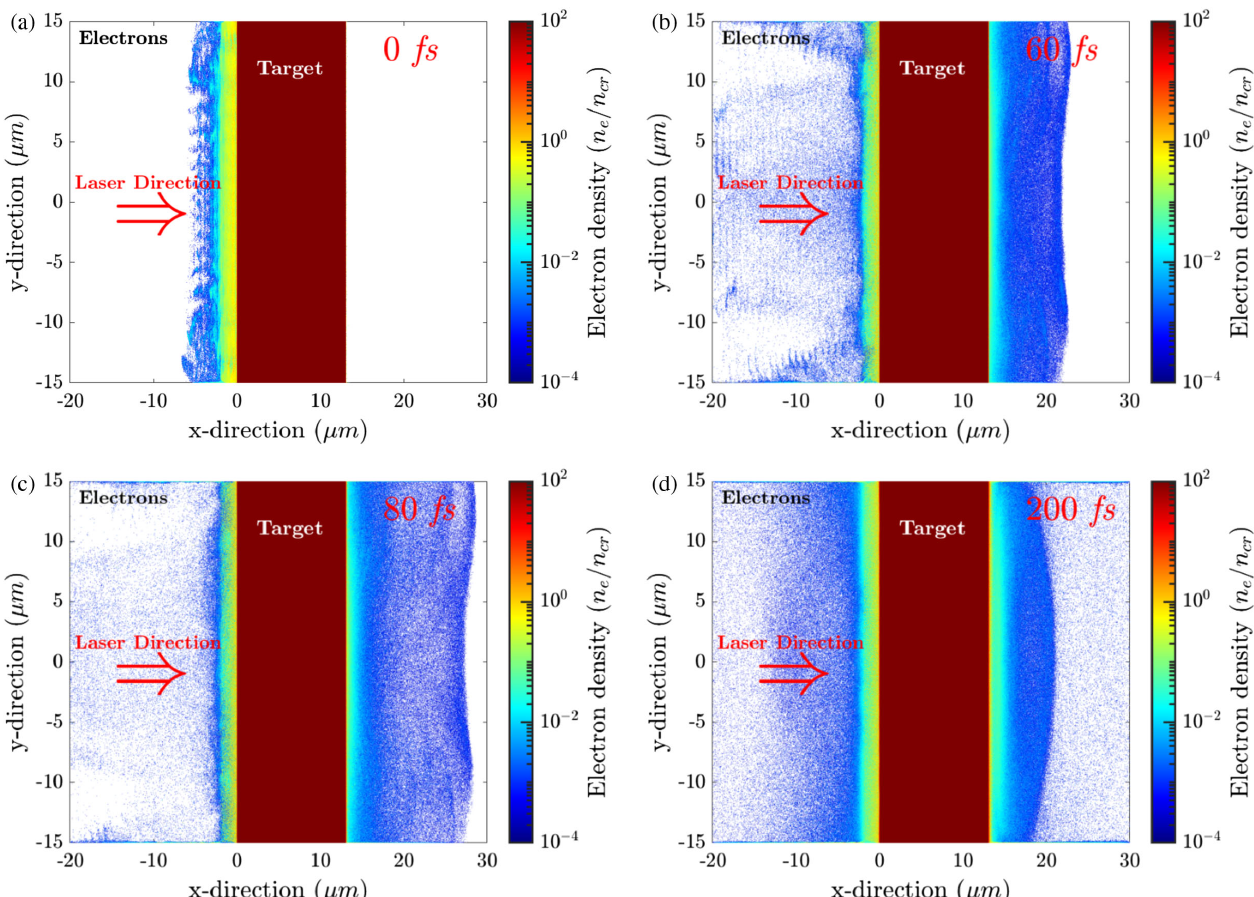
FIG. 3. 2D-PIC spatial map for emitted electrons density profile, in critical density unit, near to the target at different times starting with the laser interaction: 0, 60, 80, and 200